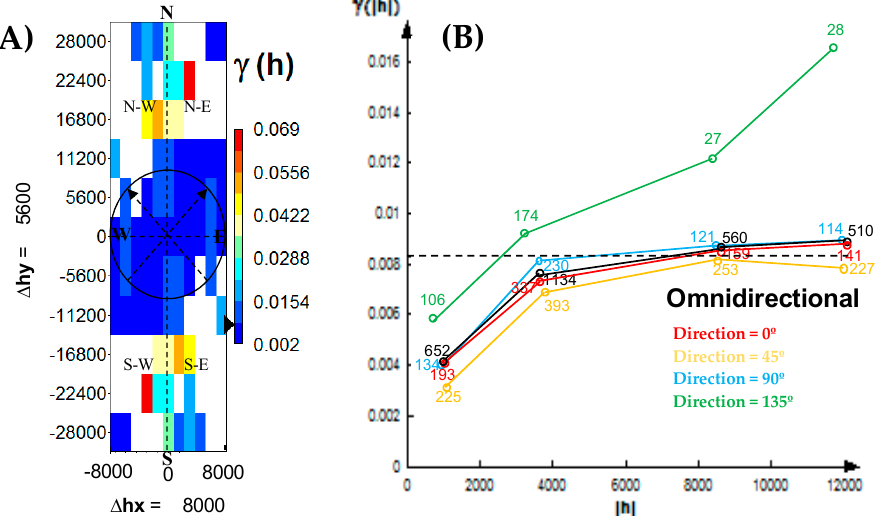
Figure A5. ( A ) Variographic surface; ( B ) omnidirectional and directional variogram—Bel é m urban zone. Figure B5. (A) Variographic surface; (B) omnidirectional and directional variogram—Belém urban zone.